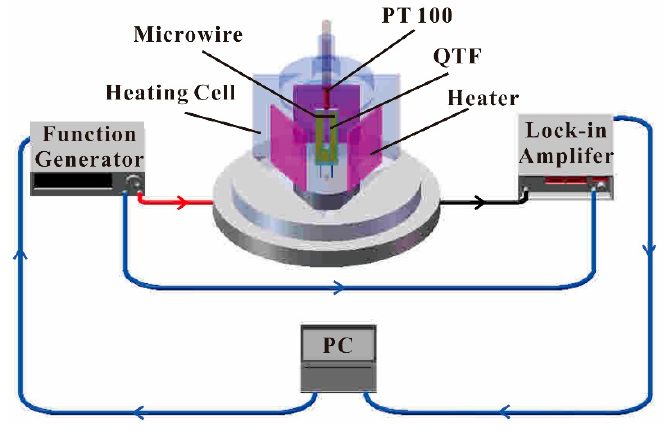
Figure 2. Schematic of the experimental setup.